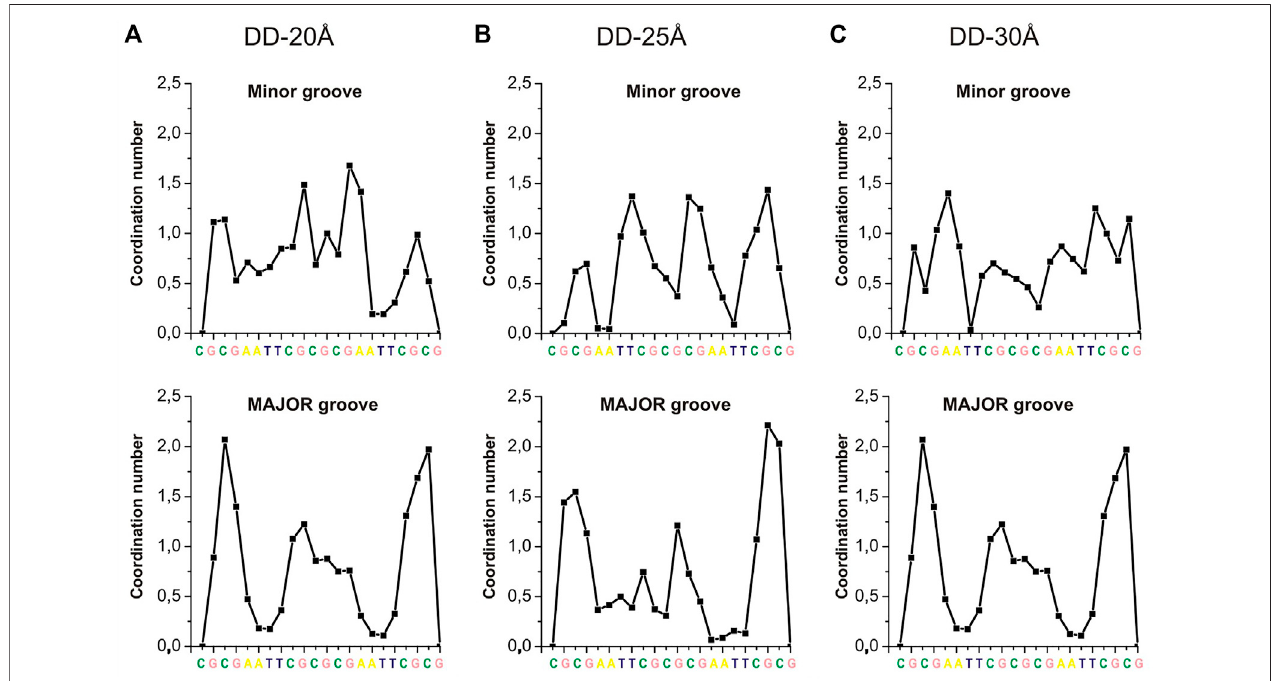
FIGURE 9 | CNs of Spd 3+ (calculated separately for each DNA base, integrating the corresponding RDFs up to 4.55 Å) in the minor and major grooves of: (A) DD- 20 Å system; (B) DD-25 Å system; (C) DD-30Å system.